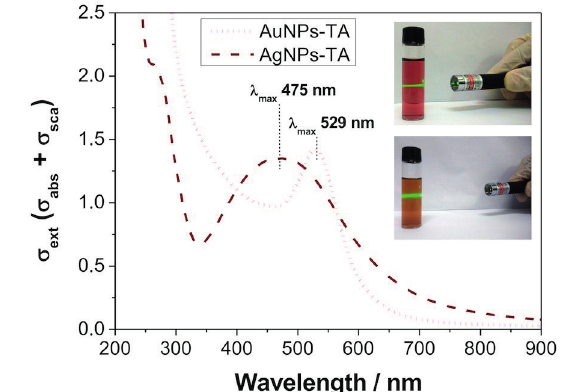
Figure 2 - UV-Vis electronic spectra for colloidal dispersions of coated nanoparticles. Inset: Tyndall effect observed for each dispersion.